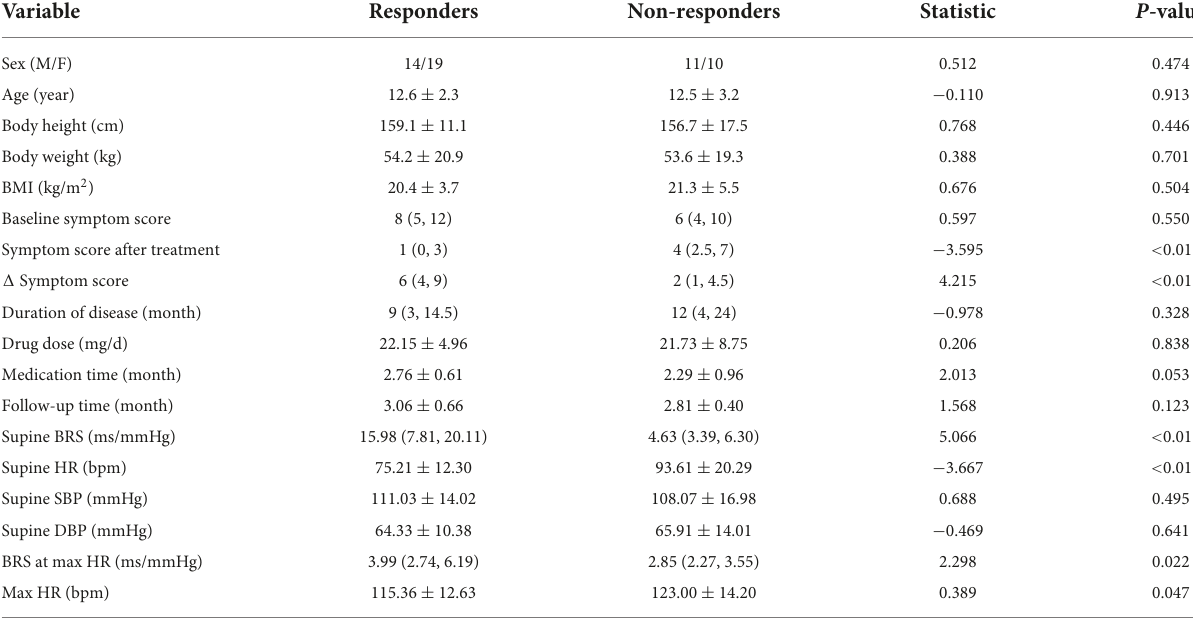
TABLE 1 Comparison of baseline characteristics between responders and non-responders.